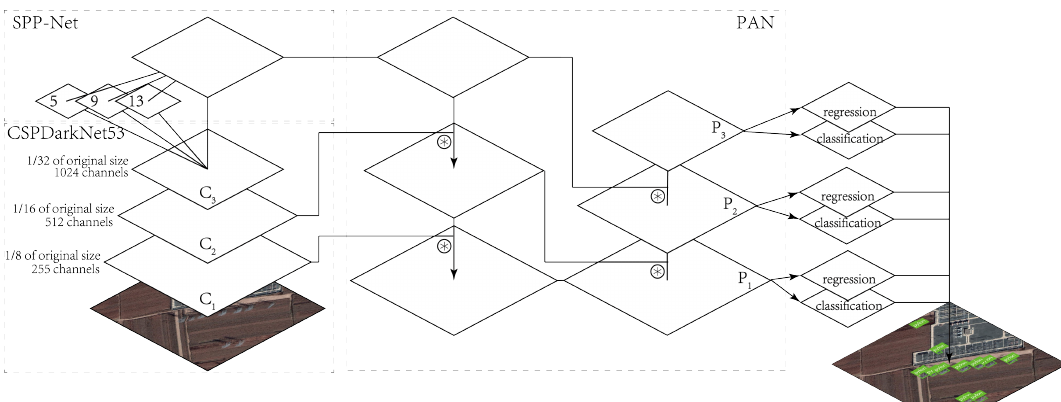
Figure 11. Structure of YOLOv4 [28]. The same as Darknet-53, C 1 – C 3 refer to the feature layers of the last three scales obtained after five down-sampling of the input image. CSPDarknet-53 also uses the structure of CSPNet [44] and the Mish activation function. SPP refers to spatial pyramid pooling, and C 3 layer are disposed with 5 × 5, 9 × 9, and 13 × 13 pooling operations, respectively. P 1 – P 3 are obtained from C 1 – C 3 feature layers after aggregation of adjacent layers through two times of down-sampling and up-sampling. (cid:126) refers to the aggregation